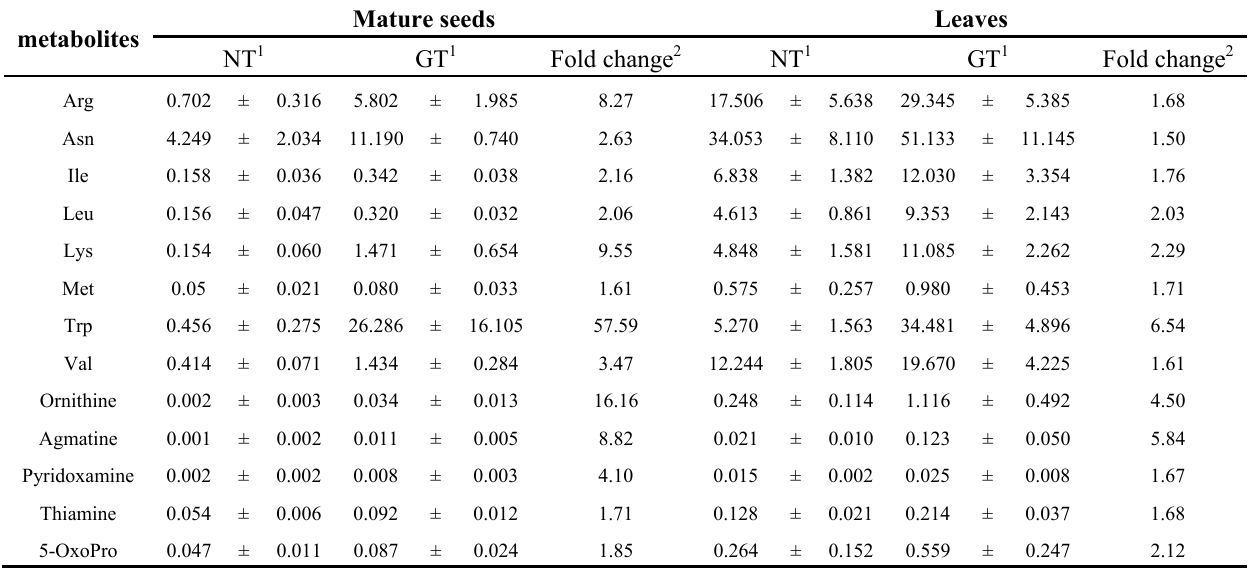
Table 1. Primary and secondary metabolites whose levels were significantly increased (>1.5-fold higher) in both mature seeds and leaves in GT plants compared to non-transformants.